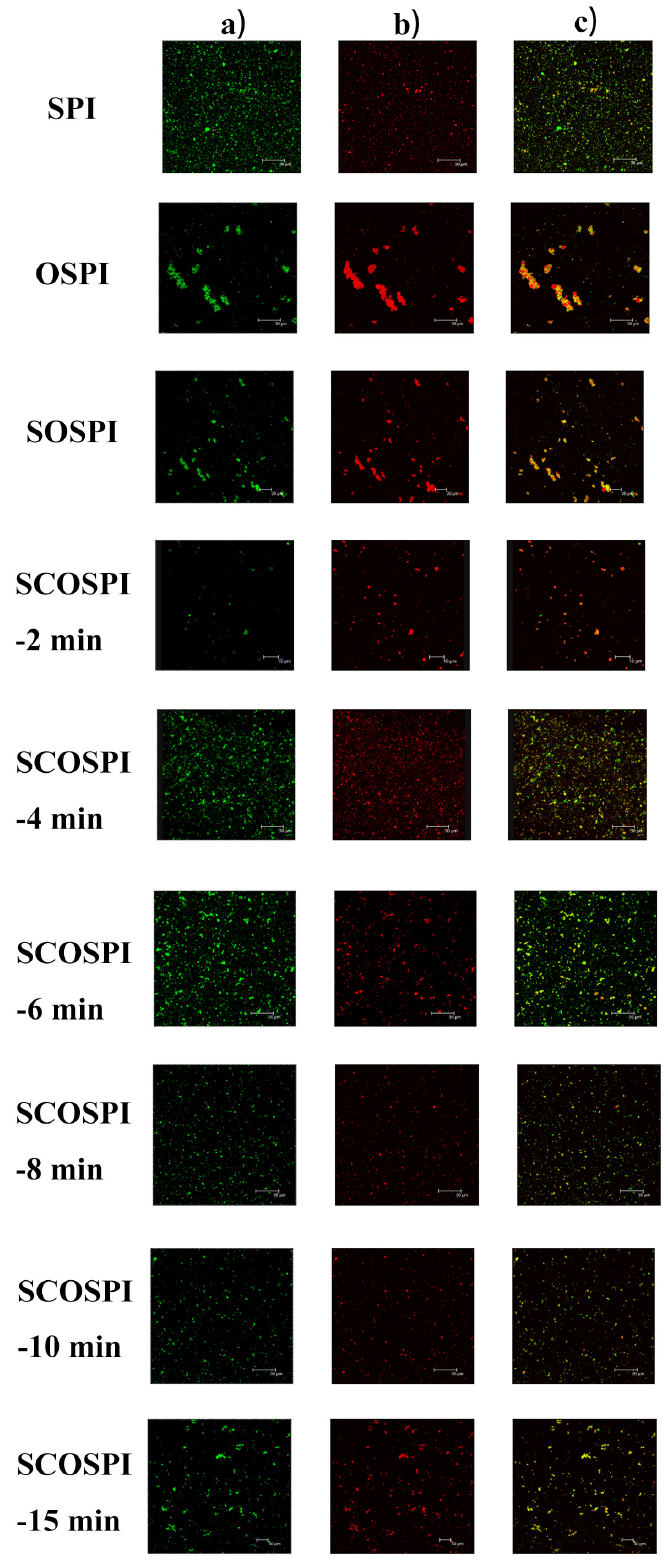
Figure 6. CLSM micrographs of natural, oxidized soybean protein, and cavitation jet treated on soluble soybean protein oxidized accumulates at several times (2, 4, 6, 8, 10, and 15 min). Note: ( a ) represents the proteins, ( b ) represents the oil droplets, and ( c ) represents the proteins adsorbed on the oil